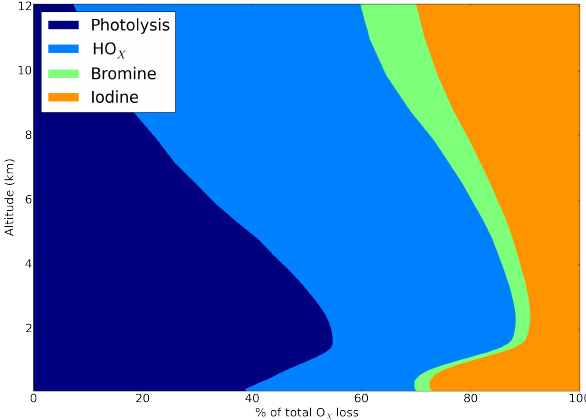
Figure 13. Vertical profile of simulated fractional global annual mean O X loss by route in the “Br + I” simulation. O X definition is given in footnote 1. Photolysis represents loss of O X due to O 3 pho- tolysis in the presence of water vapour. HO X loss includes routes via minor NO X channels. The magnitude of the bromine route is probably underestimated, as discussed in Sect.